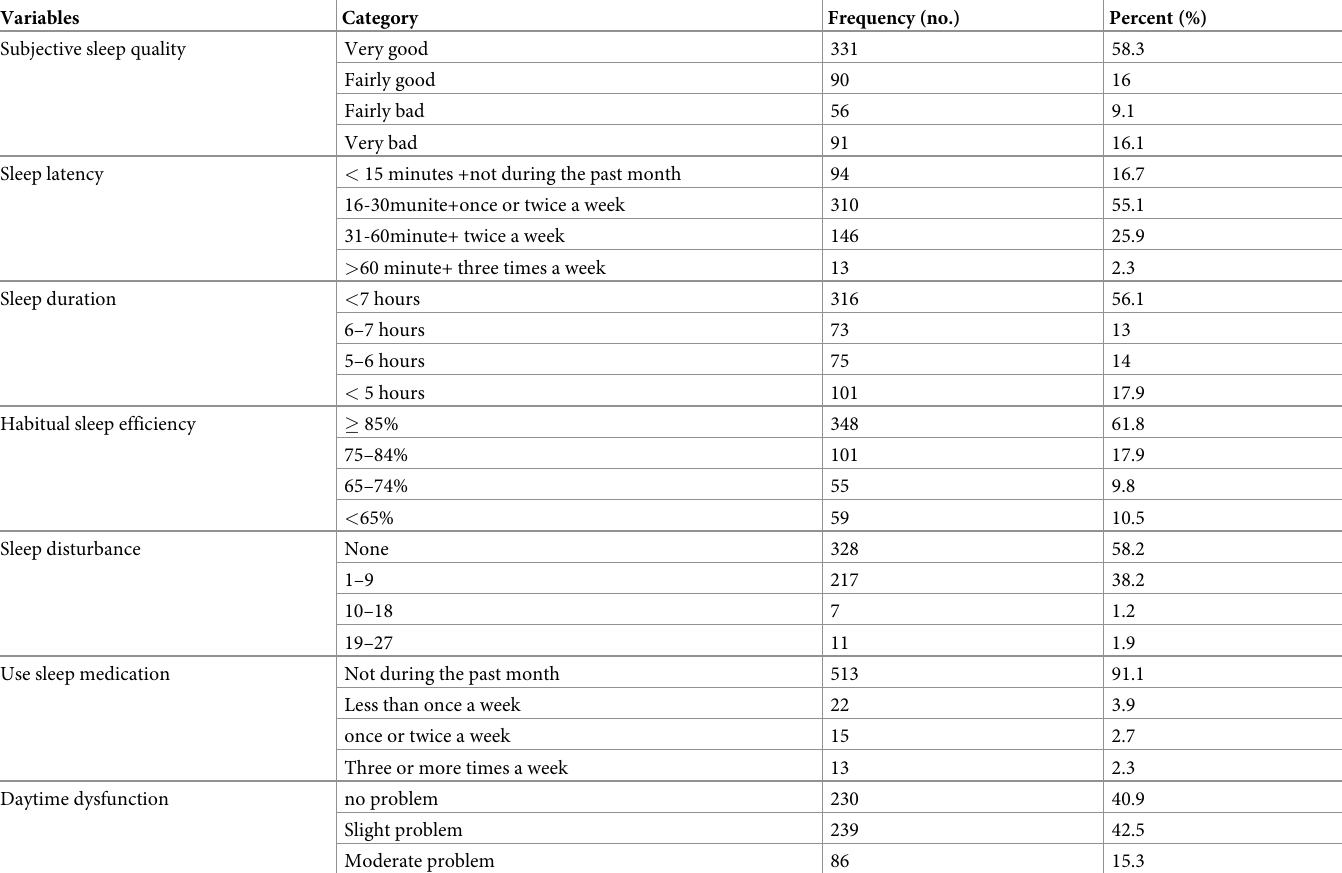
Table 4. Adult HTN patients’ sleep characteristics at chronic follow-up care clinics in northwest Amhara regional state referral hospitals, Northwest Ethiopia, 2021 (n =